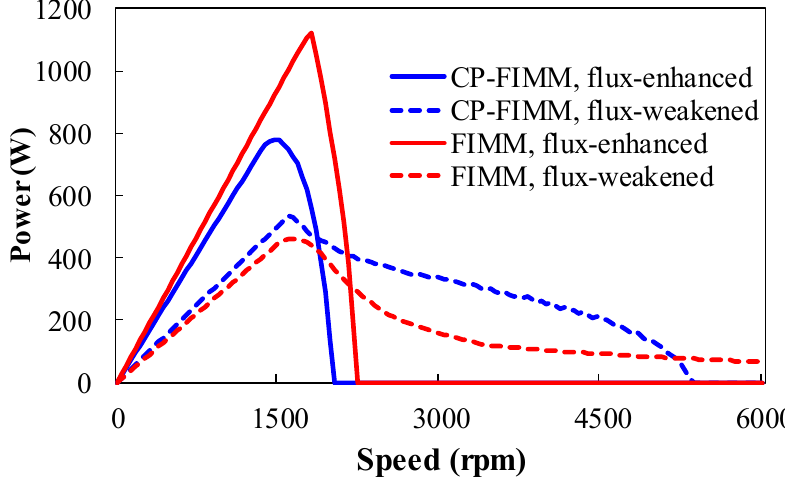
Figure 15. Power-speed waveforms of the CP-FIMM and FIMM under different MSs.